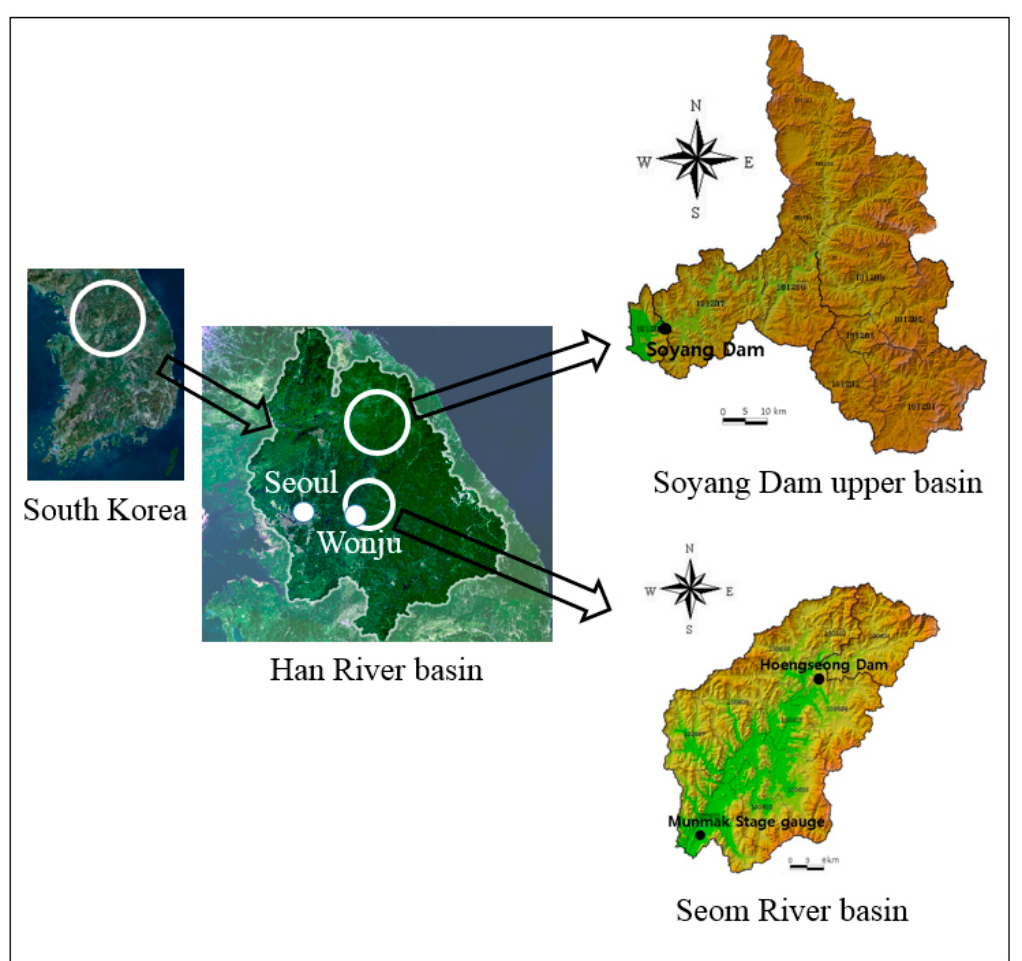
Figure 1. Configuration map of the two selected basins.